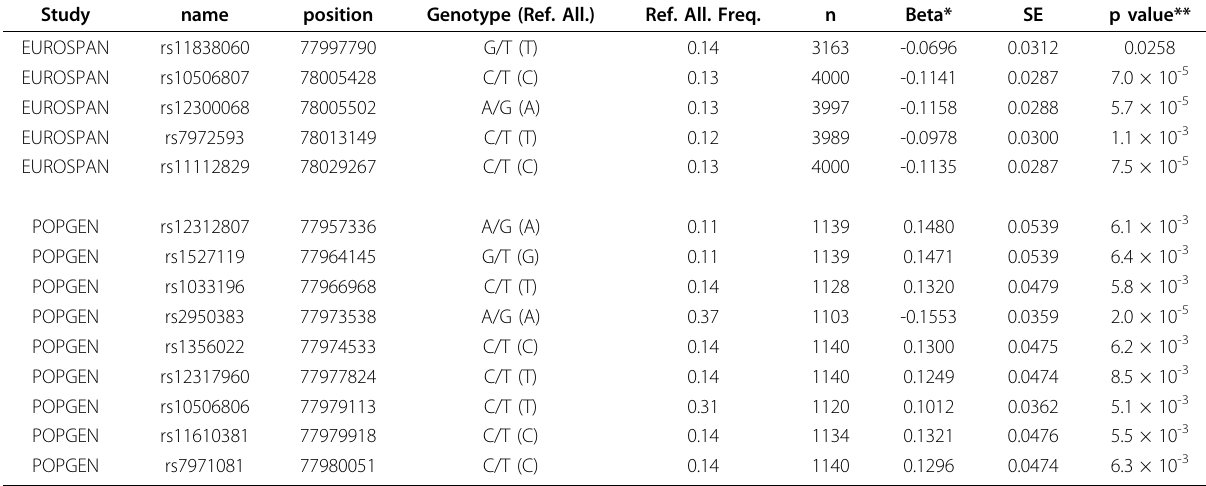
Table 3 SNPs with the highest evidence of association in the region upstream the SYT1 gene. # Study name position Genotype (Ref.